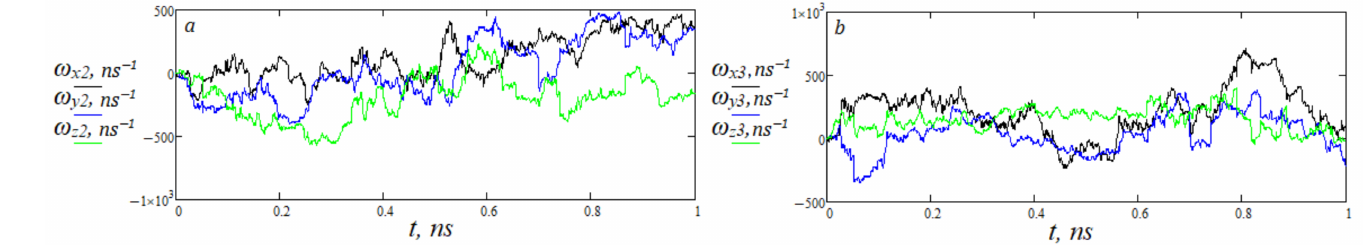
Figure 3. Projections of the angular velocities of fullerenes. ( a )—the case of "frozen" fullerenes. ( b )—case of free fullerenes.